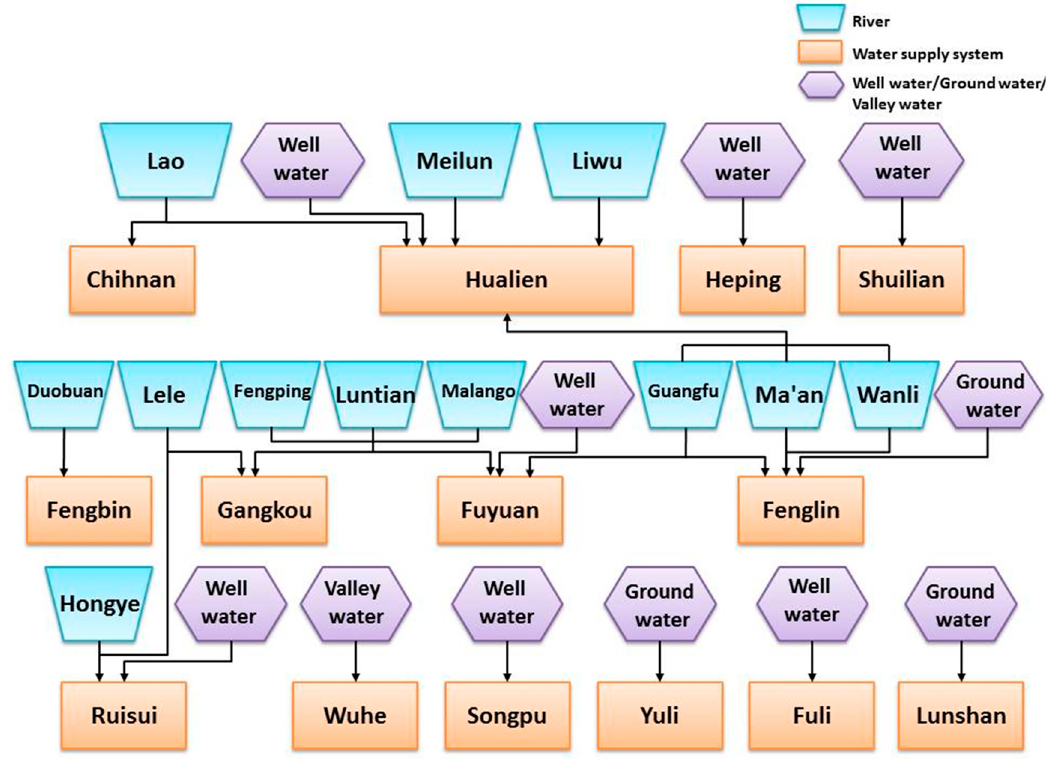
Figure 2. Hualien area water-supply system [37, 41].